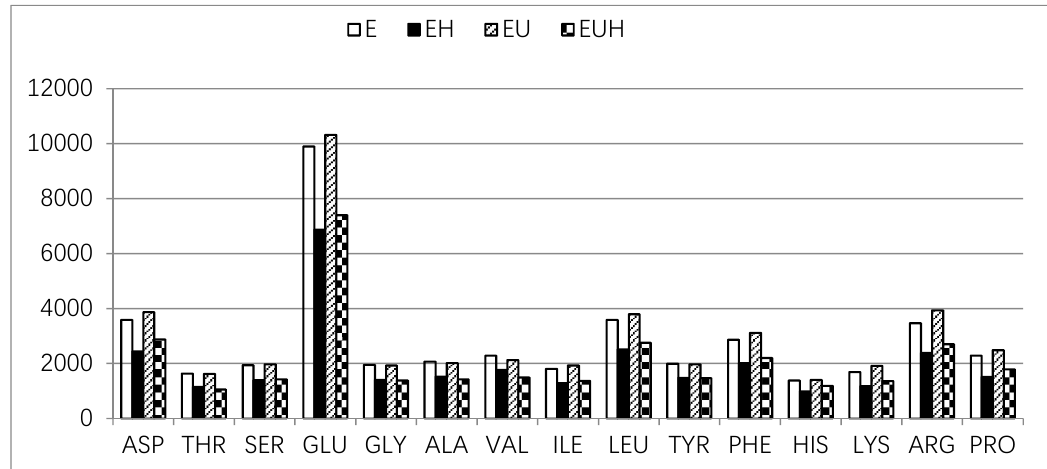
Figure 4. The amino acid absorption of oat protein hydrolysates in different groups.